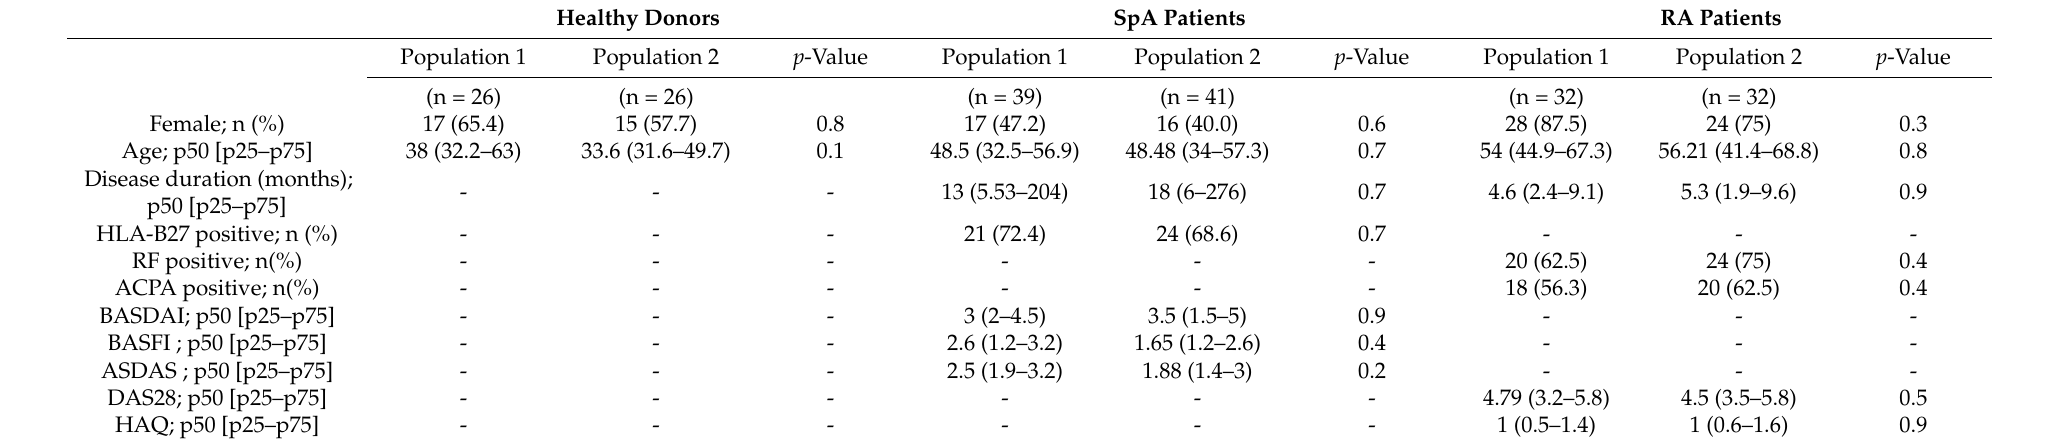
Table 1. Baseline characteristics of the populations